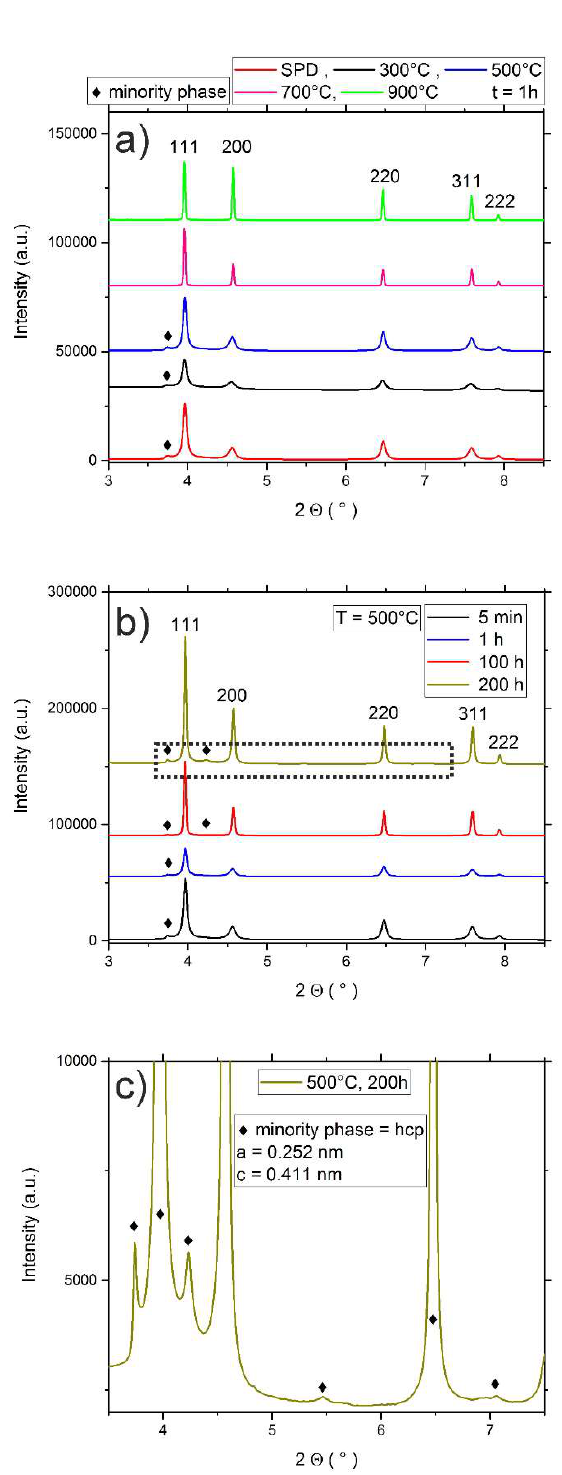
Figure 8. ( a ) Synchrotron XRD measurements of isochronally (t = 1 h) annealed samples. For the HPT processed sample, as well as for annealing temperatures up to 500 ◦ C, the minority phase can still be seen in addition to the fcc phase. For higher temperatures it can no longer be detected utilizing XRD. ( b ) Isothermal, T = 500 ◦ C, annealed samples – peak width gets continuously reduced due to a decrease in defect density. For the 200 h annealed samples the minority phase can be identified to be a hcp phase, see detailed view in ( c